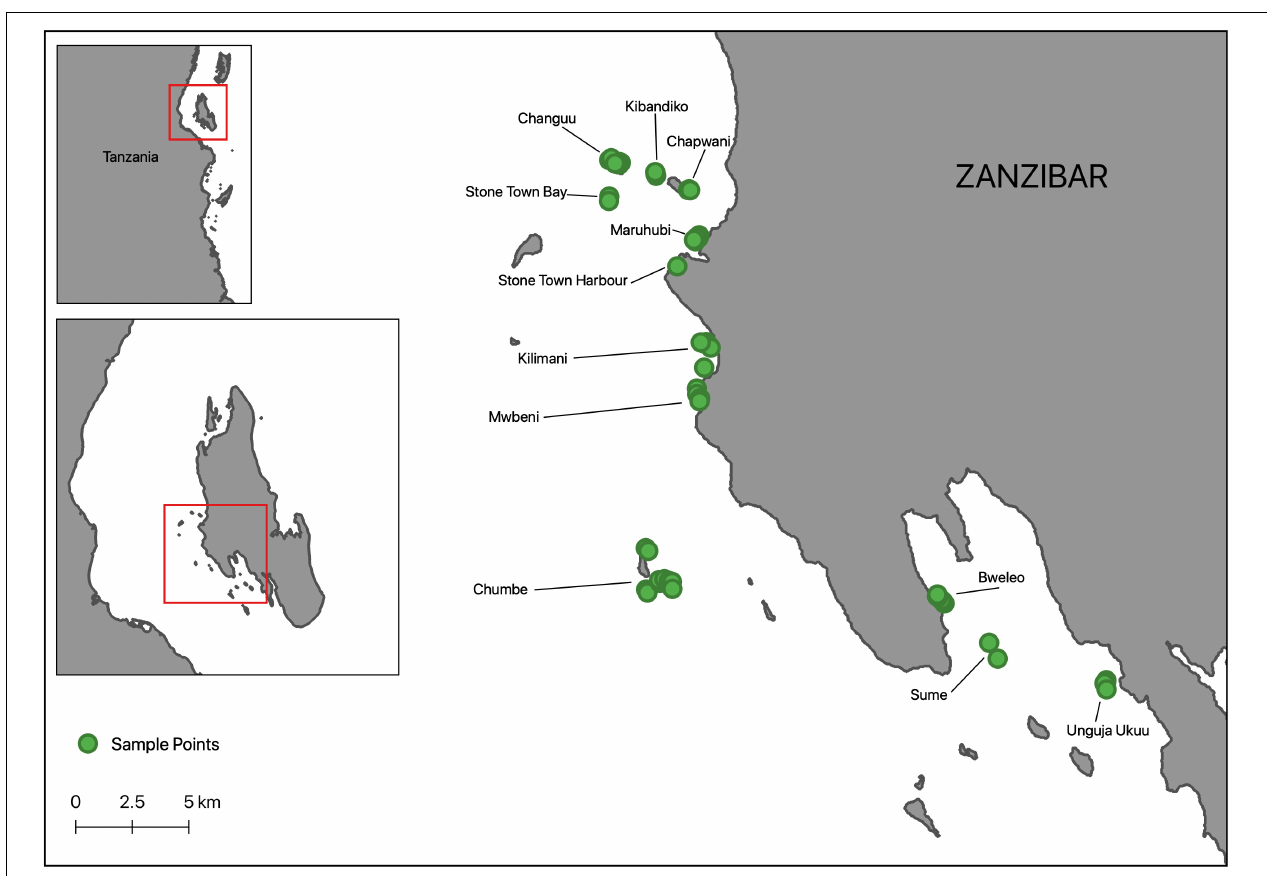
FIGURE 1 | Map of Zanzibar, Tanzania showing the location of 55 plots, nested within 12 distinct sites (identifiable by names), where fish assemblage and seagrass surveys were conducted during October-November